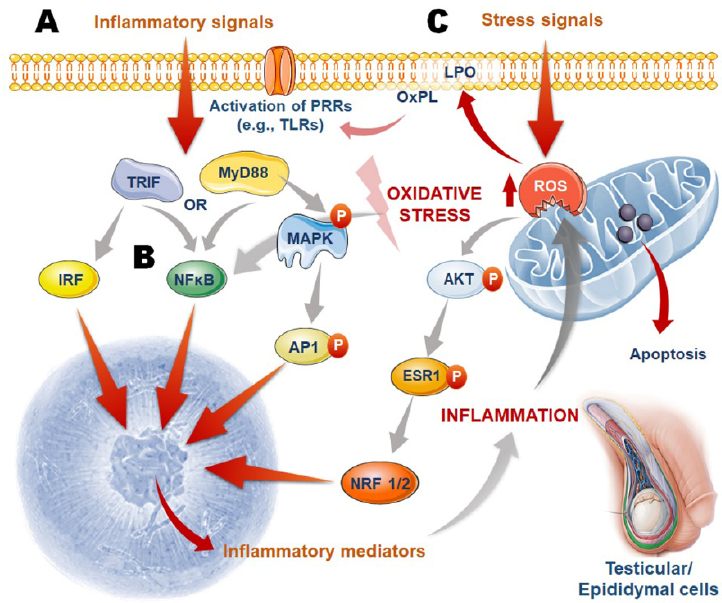
Figure 2. Cellular pathways connecting inflammation and oxidative stress (OS) in the pathogenesis of male infertility. ( A ) Pattern recognition receptors (PRRs) in testicular and epididymal cells are activated by inflammatory stimuli. The activated PRRs trigger downstream signalling via the Myeloid differentiation primary response (MYD88) and mitogen-activated protein (MAP) kinases pathways (IRF3); ( B ) These cascades activate transcription factors such as the nuclear factor kappa light chain enhancer of activated B cells (NF-kB), activator protein 1 (AP-1), and interferon regulatory factor 3 (IRF3); ( C ) Excess ROS production, on the other hand, can cause oxidation of membrane phospholipids and intracellular proteins, which can activate the PRRs-inflammatory pathway. Furthermore, ROS can activate the transcription factors nuclear respiratory factor (NRF) 1 and 2 via AKT (Protein Kinase B) and estrogen receptor (ESR) 1. These activated transcription factors induce the expression of inflammatory mediators such as tumour necrosis factor α (TNF α ), interferons (IFNs), interleukin (IL) 1, nitric oxide (NO), and tumour growth factor (TGF) B3, which cause exaggerated inflammation and can also act as OS stimuli, creating a feedback loop. OS can also initiate apoptotic cascades by assisting the release of cytochrome-c (Cyt-c) from mitochondria.